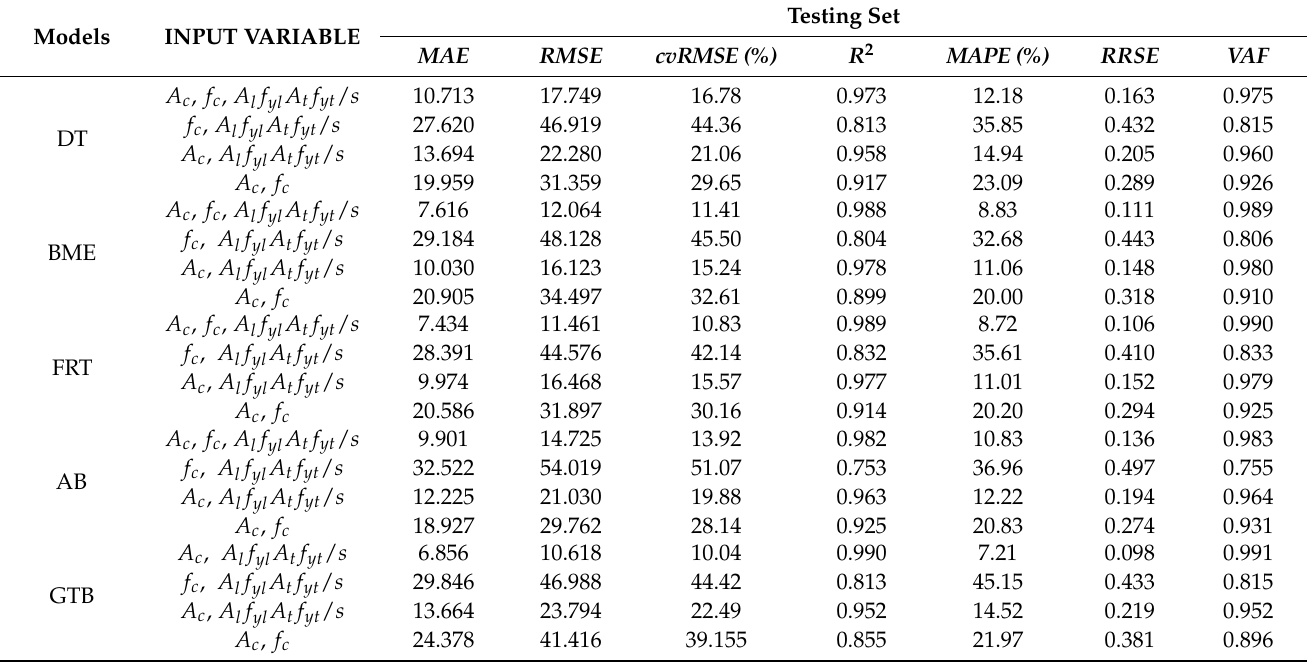
Table 8. Effect of input variables on the performance of the ML